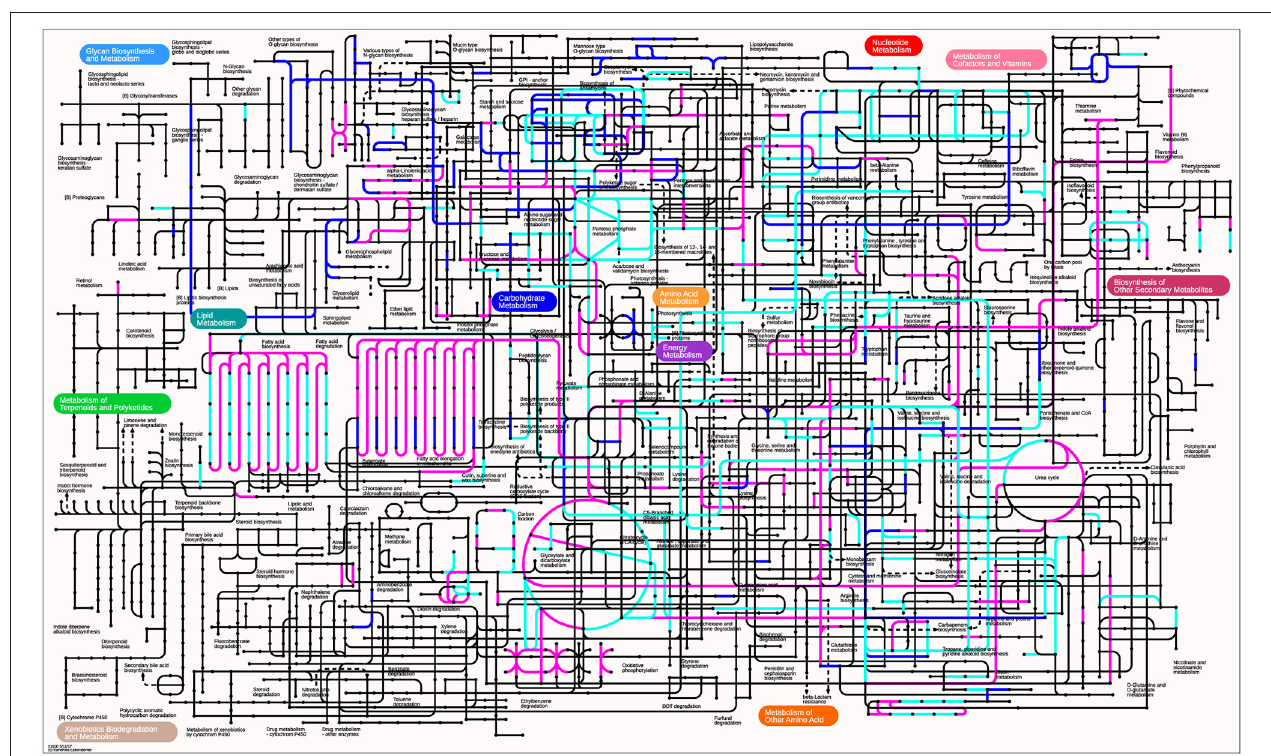
FIGURE 6 | KEGG atlas of the metabolic pathways found in the pozol metaproteome. The proteins identified only in bacteria and fungi are shown in blue. Proteins identified only in plants are shown in pink. The cyan lines indicate common proteins.